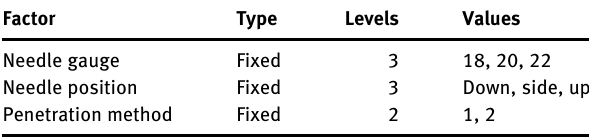
Table  : General linear model – coring vs. needle gauge, needle position, and penetration method.